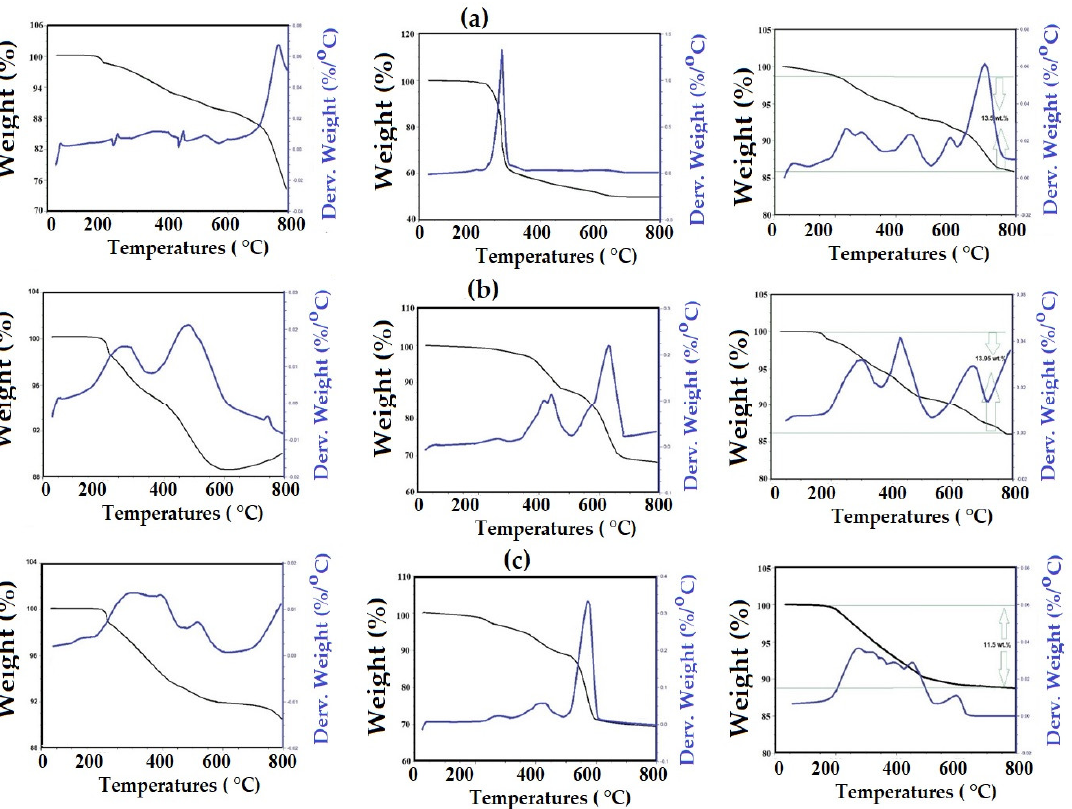
Figure 8. TGA-differential thermogravimetric analysis (DTG) thermograms ordered from left to right as Fe 3 O 4 , Ag and TiO 2 NPs capped with ( a ) EOA, ( b ) ELOA and ( c ) ELNA.